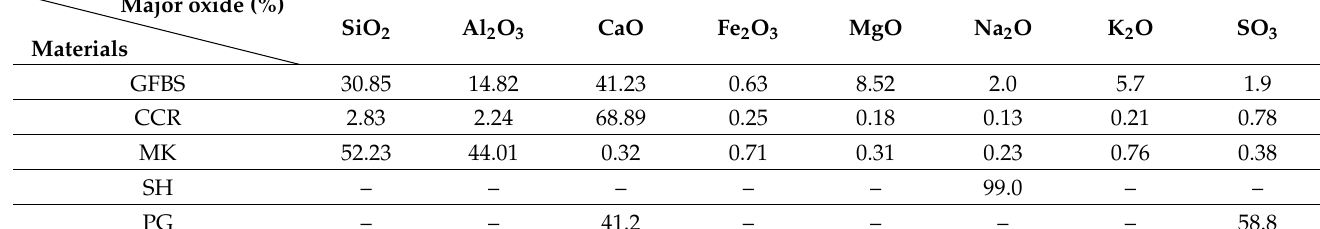
Table 4. Main chemical composition of materials used.